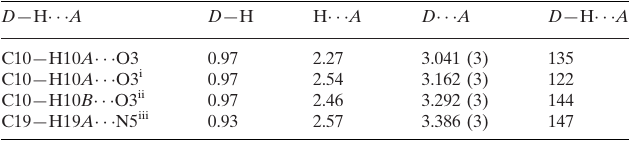
Hydrogen-bond geometry (A˚ , (cid:3)